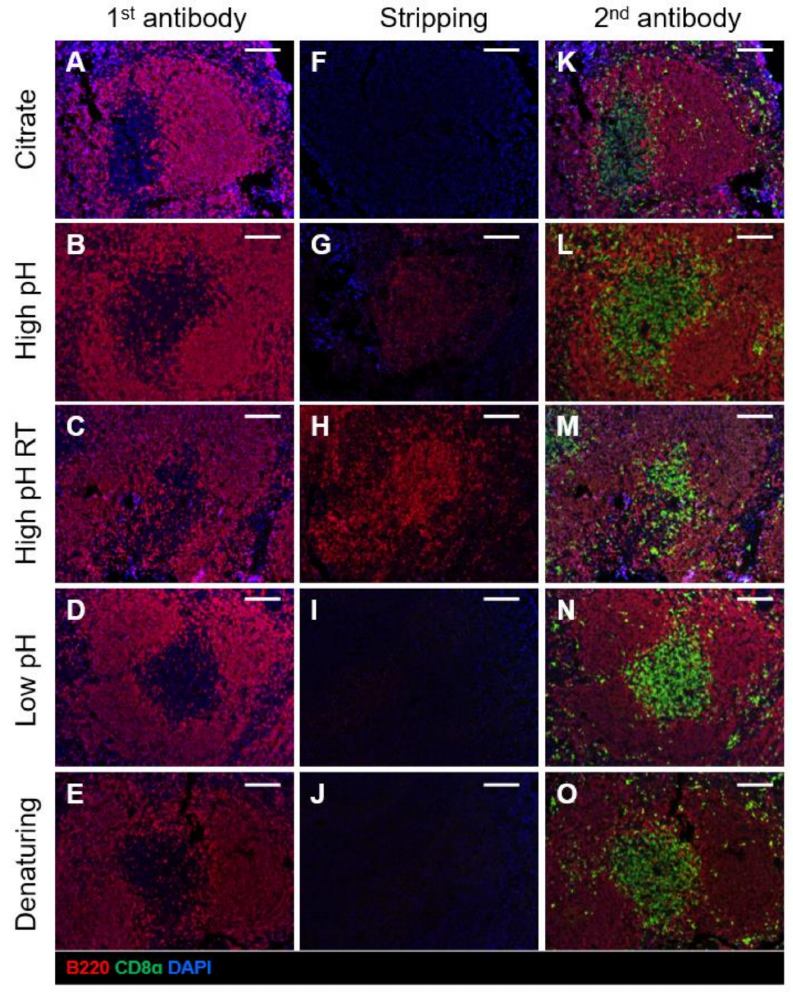
Figure 2. Assessment of antibody stripping methods. FFPE mouse spleen sections were stained with B220 (red) as the first antibody ( A – E ), followed by stripping methods listed below. Stripping efficiency was evaluated after microwave treatment in citrate buffer ( F ), incubation in high pH glycine-based buffer at 50 ◦ C ( G ) or room temperature ( H ), low pH glycine-based buffer at 50 ◦ C ( I ) and glycine-SDS denaturing buffer at 50 ◦ C ( J ). To test whether antigenicity or signal intensity of the previous marker are affected by the stripping method, sections were stained with a second antibody CD8 α (green) ( K – O ). Tissue sections were imaged at 20X magnification on Vectra 3. RT: room temperature. Scale bar: 100 µ